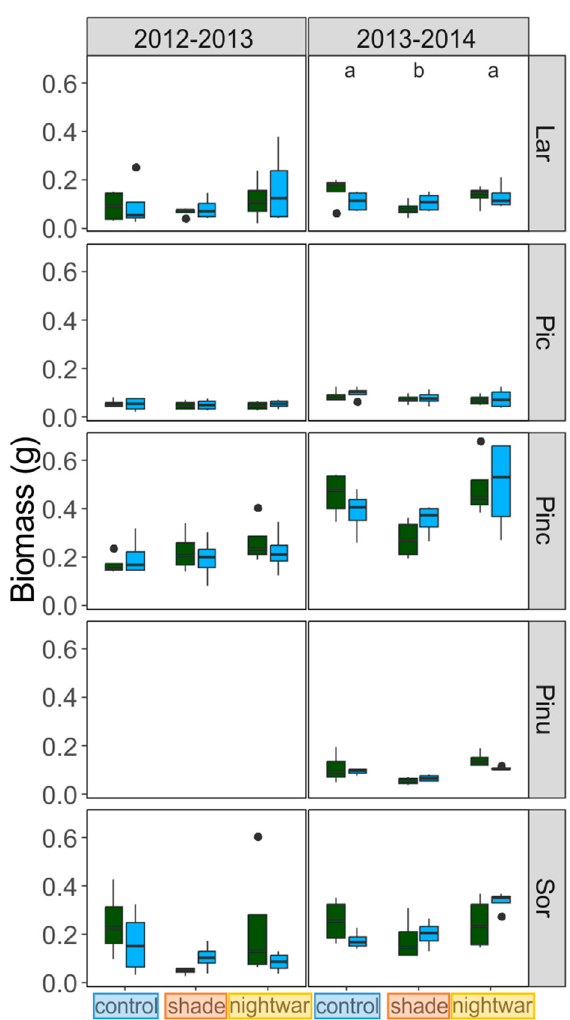
Figure 6. End-of season biomass of 1.5-year old tree seedlings near the treeline in the French Alps: Lar = Larix decidua , Pic = Picea abies , Pinc = Pinus cembra, Pinu = Pinus uncinata , Sor = Sorbus aucuparia . Seedlings planted autumn 2012 (left) and 2013 (right), measured one year later. Snow treatments: early (dark green) and late (blue); sky-exposure treatments (x-axis): control (no roof), shade (shade roof during the day), and nightwar = night warming (shade roof during the night). Box plots show medians and quartiles from four blocks, based on means of one (2013) or three (2014) seedlings per block. The letters indicate a significant effect of shade on the 2013-2014 seedlings overall, with no interaction with species.